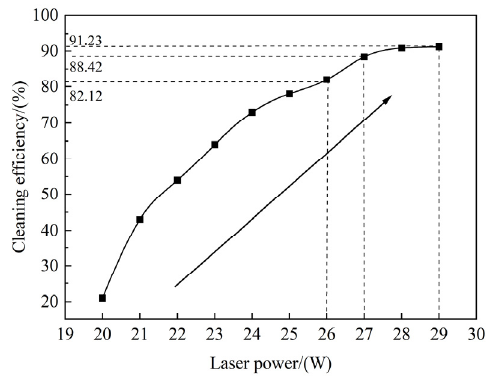
Figure 9. Relationship between cleaning e ffi ciency and laser power.